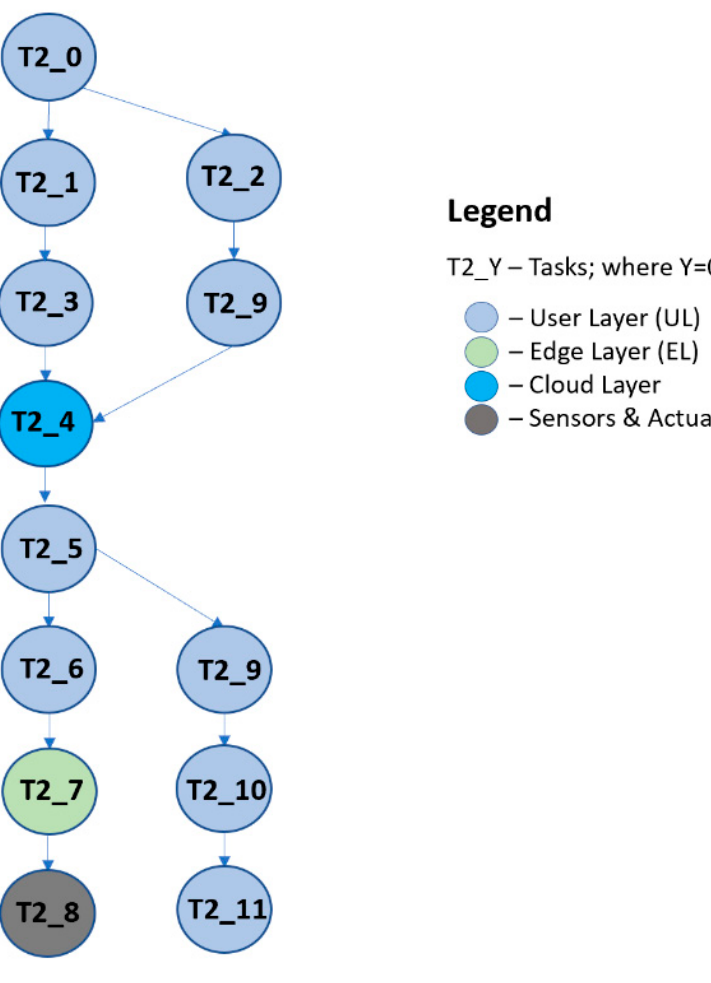
Figure 5. Task graph of basic system functions triggered from the application.